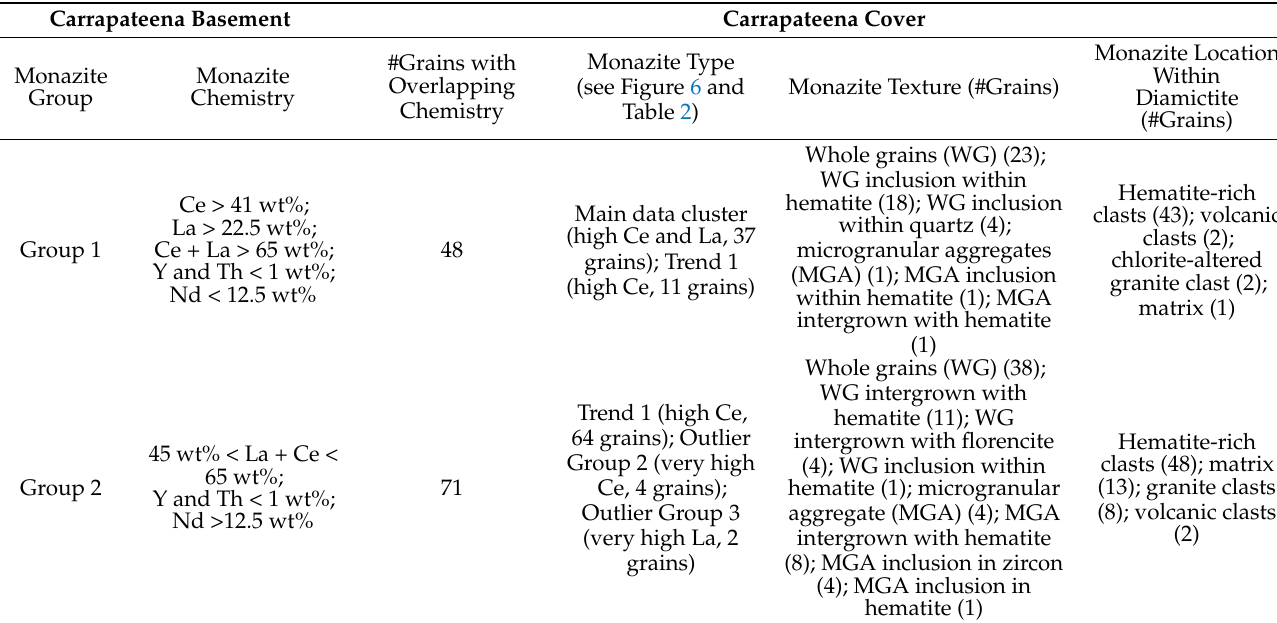
Table 3. Comparison of chemistry for Group 1 and Group 2 basement monazite chemistry with chemistry of monazite from cover sequence immediately overlying the Carrapateena deposit. Detail on the texture and location of monazite within the cover sequence is also given.